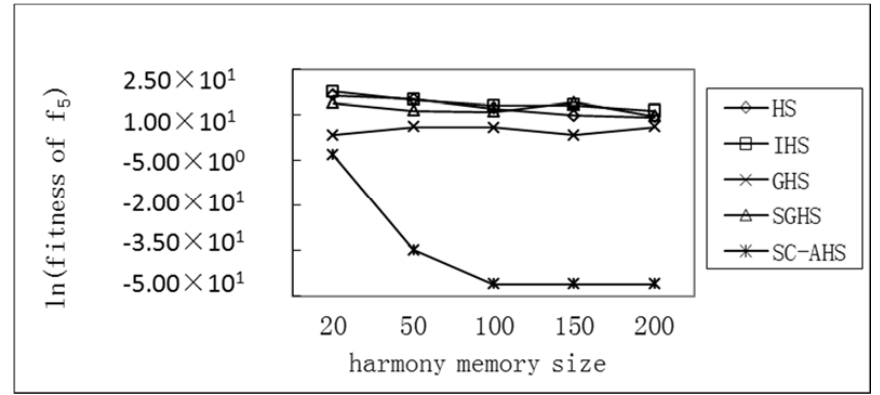
Figure 10. Comparison of the average optimum with different harmony memory sizes of the Ackley function.